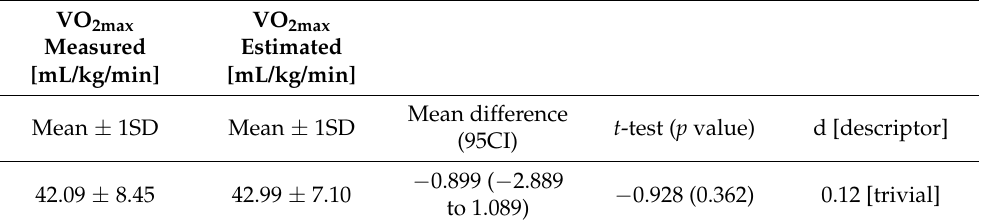
Table 2. t -test paired samples comparison between the VO 2max measured and estimated in validation group. Effect size index (Cohen’s d) is also